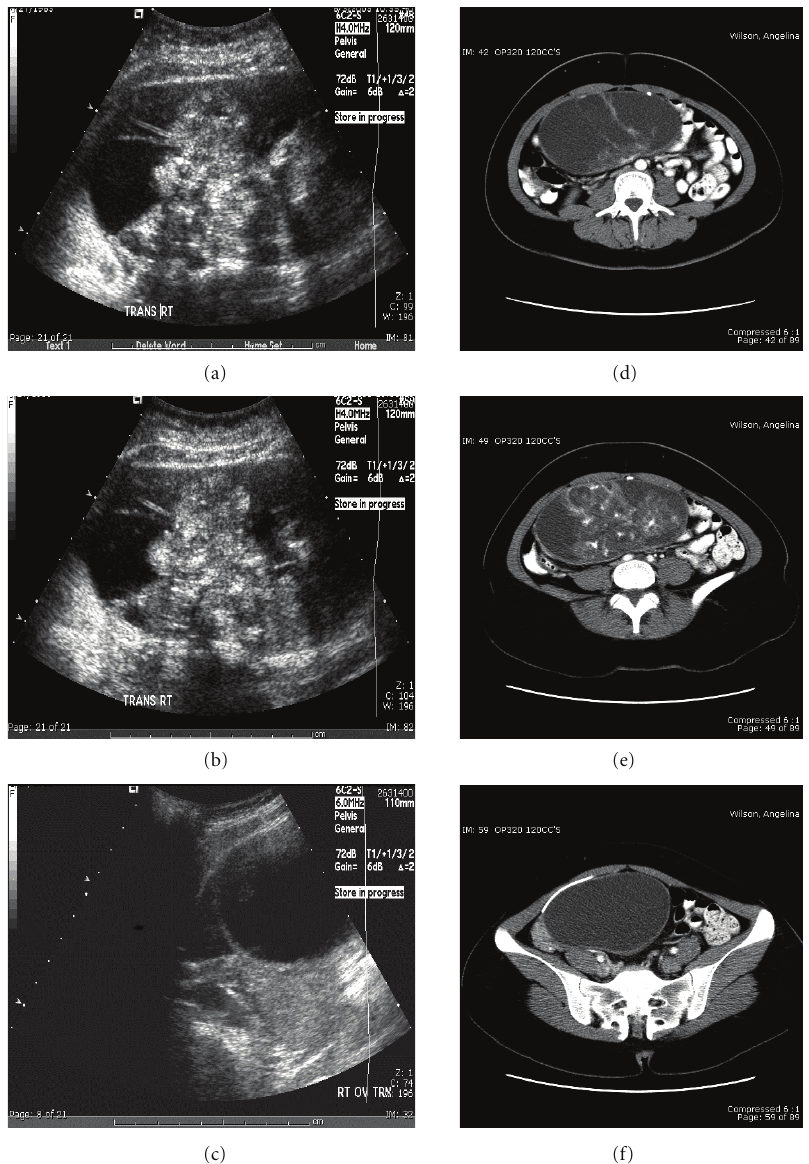
Figure 1: In figures (1a-1c), an abdominal ultrasound shows a large, walled, and multiseptated fluid collection. A small portion of the shunt catheter appears to be within this fluid collection, and thus the lesion was felt to be consistent with a pseudocyst, or CSFoma. In figures (1d-1f), a CT with IV contrast shows the same complex, multiseptated 16 × 8 × 17 cm pelvic mass emanating from the right ovary, with the distal shunt tubing draped circumferentially around the lesion, indicating that the shunt was not responsible. Surgical exploration leads to the diagnosis of